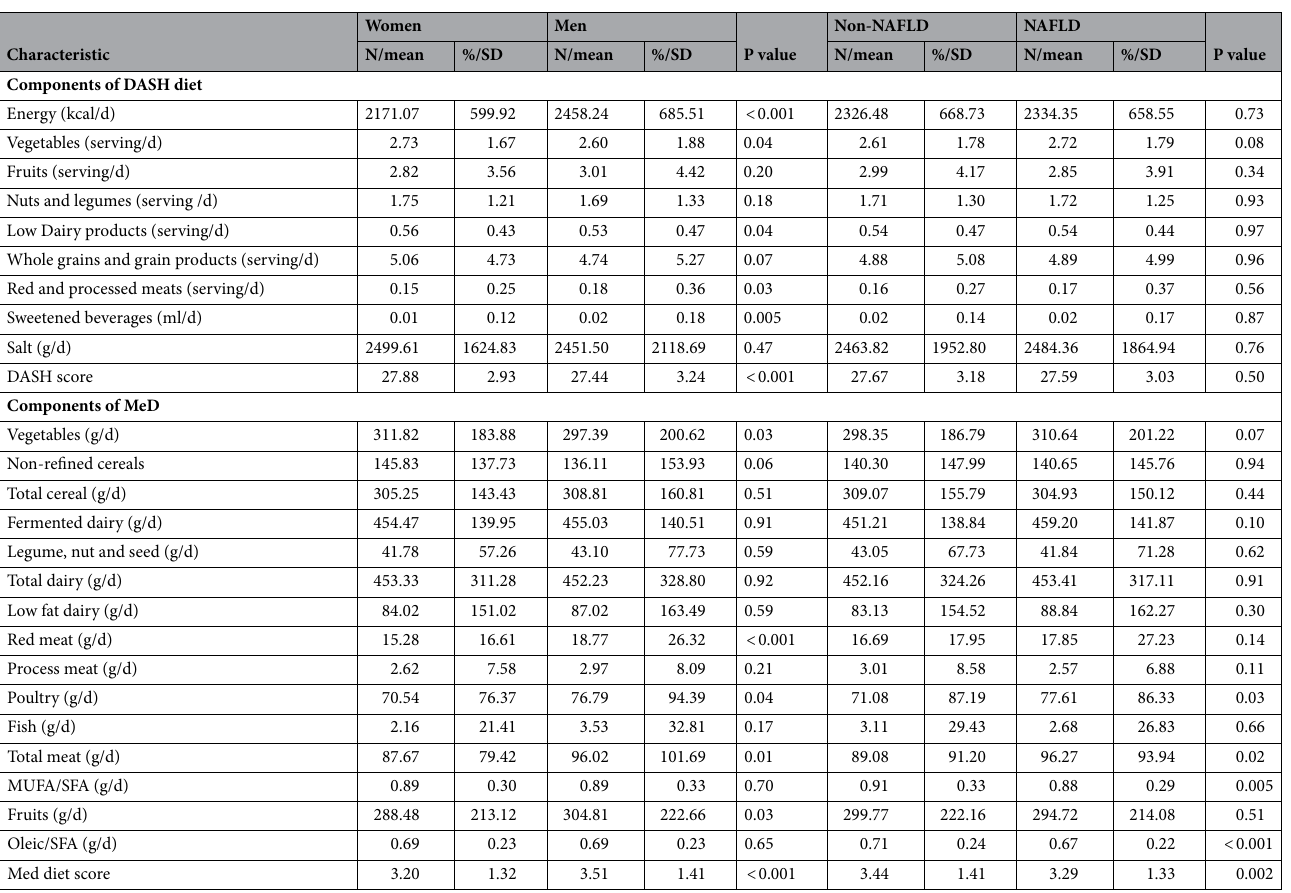
Table 2. Dietary patterns of the study adult participants (n 3220, aged ≥ 18 years), Amol Cohort Study, Iran, 2016–2017. NAFLD: nonalcoholic fatty liver disease; DASH: Dietary Approaches to Stop Hypertension,